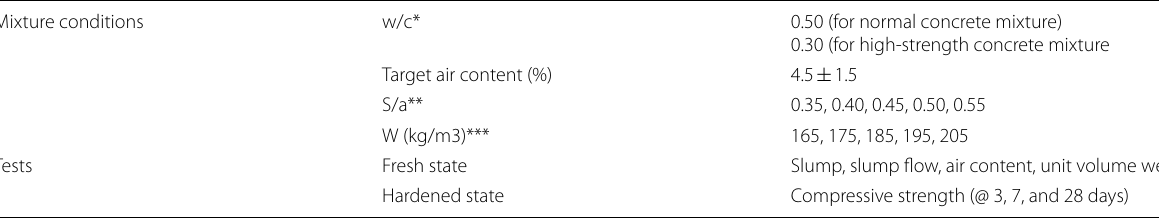
Table 1 Experimental plan.